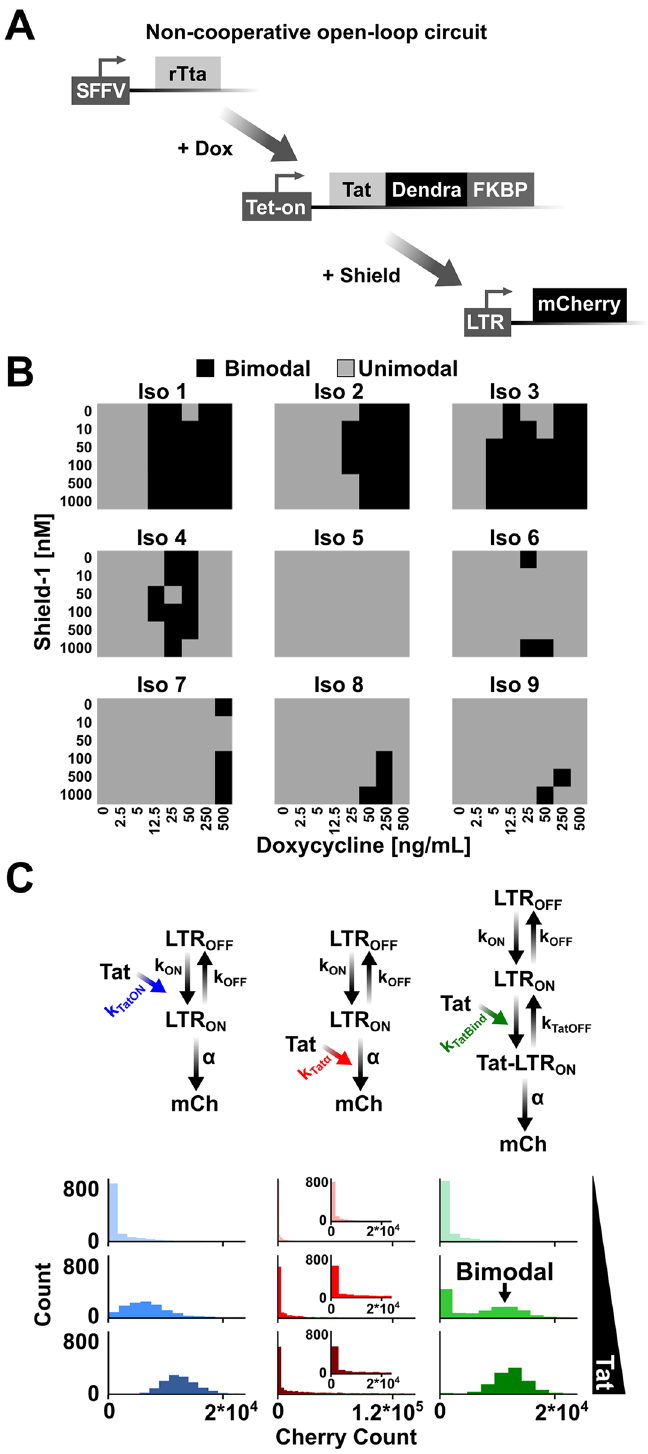
Fig 2. Long terminal repeat (LTR) promoter toggling is sufficient to generate bimodality and control HIV fate. (A) Schematicof the open-loopHIV circuit. Doxycycline additioninducestranscriptionfrom the Tet- ON promoter. Shield-1additioncontrols the stability of the transactivator of transcription(Tat) fused to Dendra-FKBP fusion protein. Tat inducestranscriptionfrom the HIV LTR. (B) The (Iso) term representsan independent isoclonalpopulation; consequently, each cell within a clone has the same integrationsite for